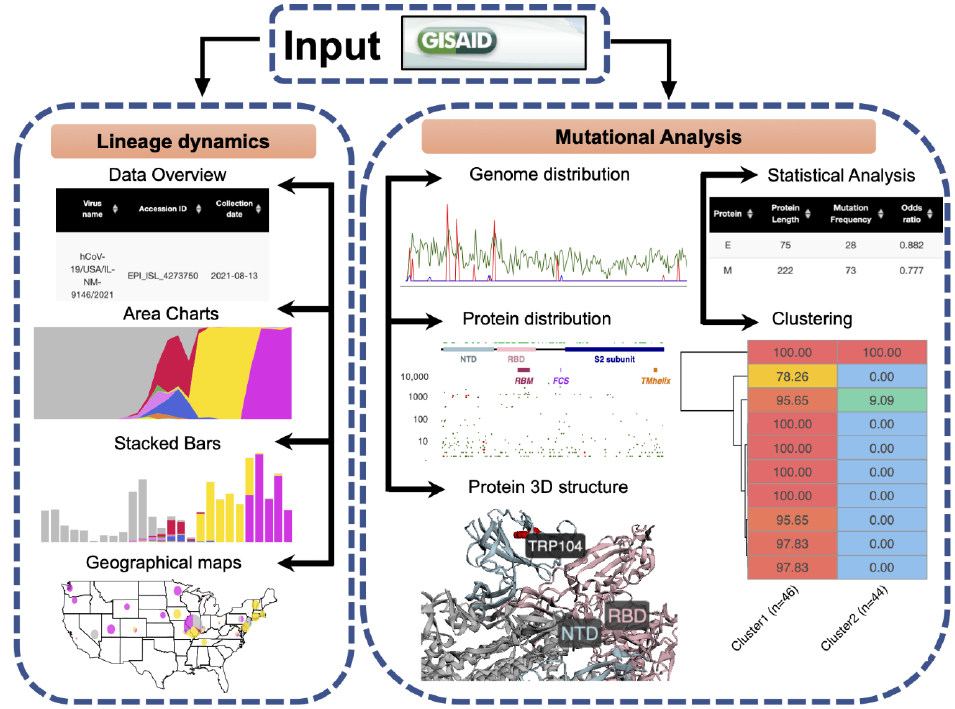
Figure 1. General workflow of ViralVar and its two main modules. Input data reflecting